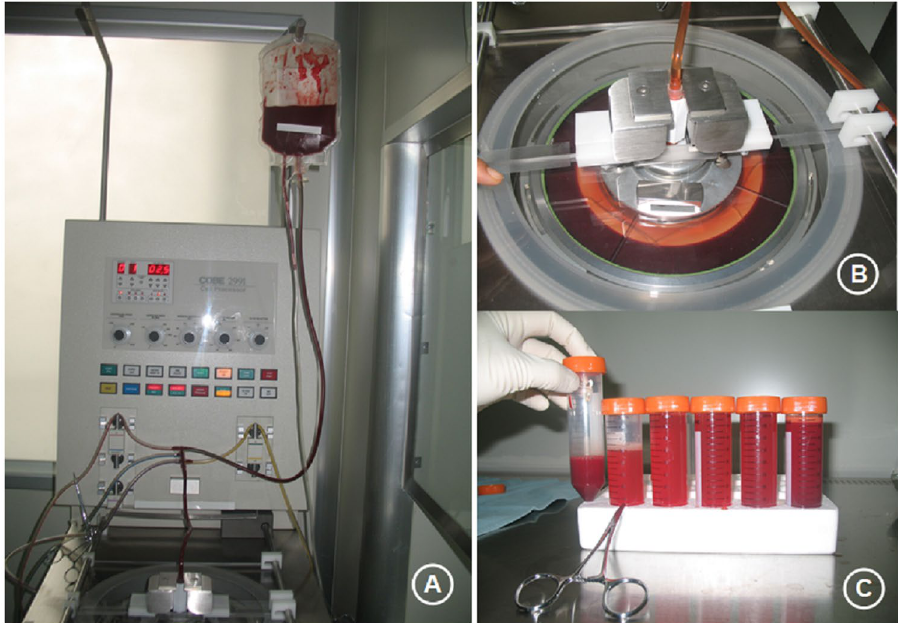
Figure 6. The harvested bone marrow was processed directly in the operating room on a cell concentrator- separator device ( A , COBE ® 2991 Cell Processor, Terumo BCT, Gambro BCT, Inc., Lakewood, USA), spinning at 2000 rpm for 5 minutes ( B ) to separate bone marrow components. These components were stratified according to density and plasma; bone marrow mononuclear cells (BMMCs) and red blood cells were located from the inner to outer layers ( C ). Note: The patient consented to publish the specific information.